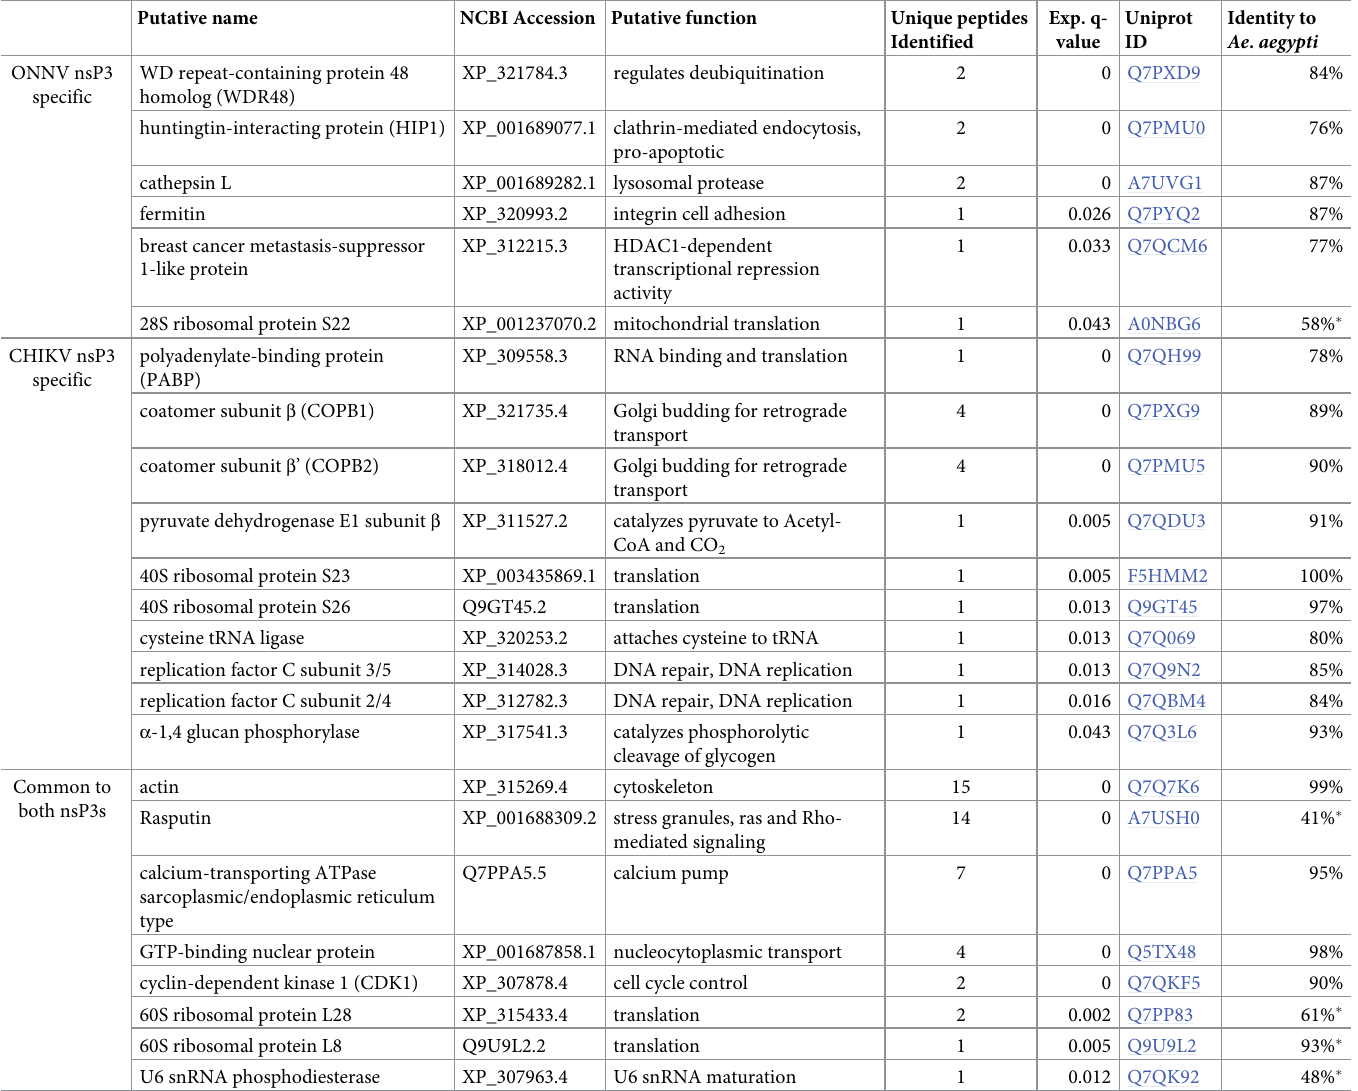
Table 1. Proteins found in duplicate nsP3 precipitations. Percent identity between the anopheline proteins and the Aedes aegypti homolog were provided by NCBI’s BLAST [29]. All homologs had 98% or greater query coverage, except for those marked by � . For these protein alignments with < 98% coverage the percent identity was manually calculated by summing BLAST-determined identical amino acids divided by the Aedes protein amino acid